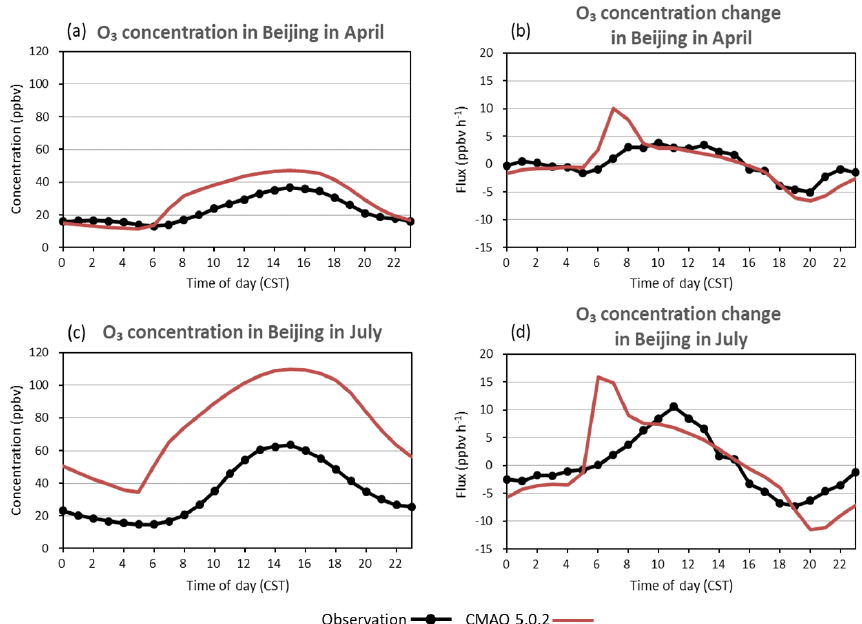
Figure 7. Monthly averaged diurnal variation in (a) O 3 concentration in April, (b) hourly O 3 concentration change in April, (c) O 3 concen- tration in July, and (d) hourly O 3 concentration change in July in Beijing.